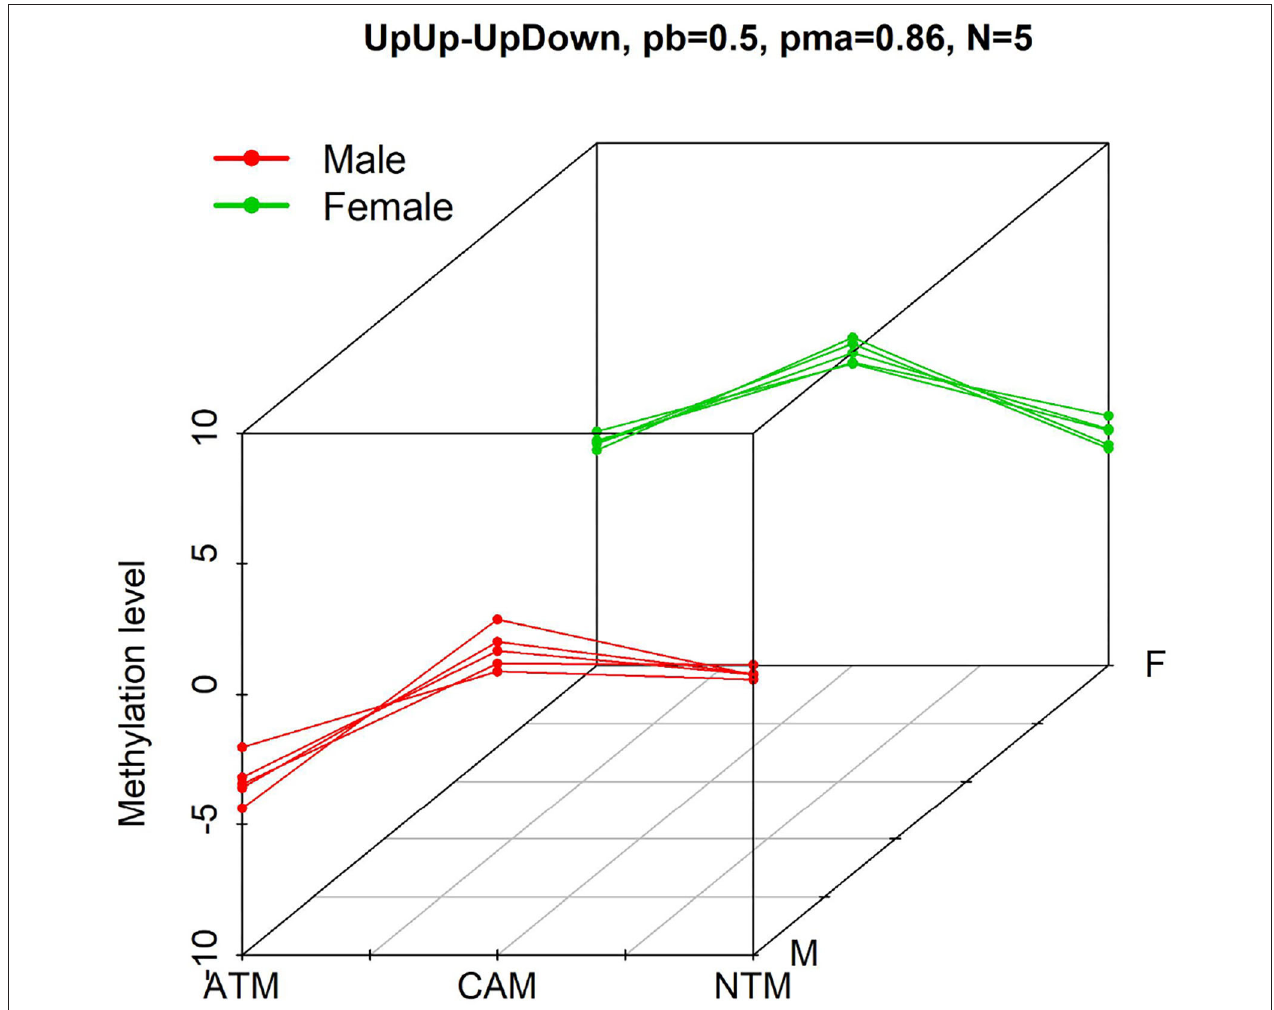
FIGURE 1 | Example of probes with differential methylation level pattern, UpUp-UpDown, among three groups when comparing male (red—UpUp trajectory in this example) to female (green—UpDown trajectory in this example) samples. “ N = 5” means that five differential methylation probes from GSE97686 dataset belong to this pattern with probability larger than pb = 0.5. pma = 0.86 means that the maximum probability to belong to this pattern is